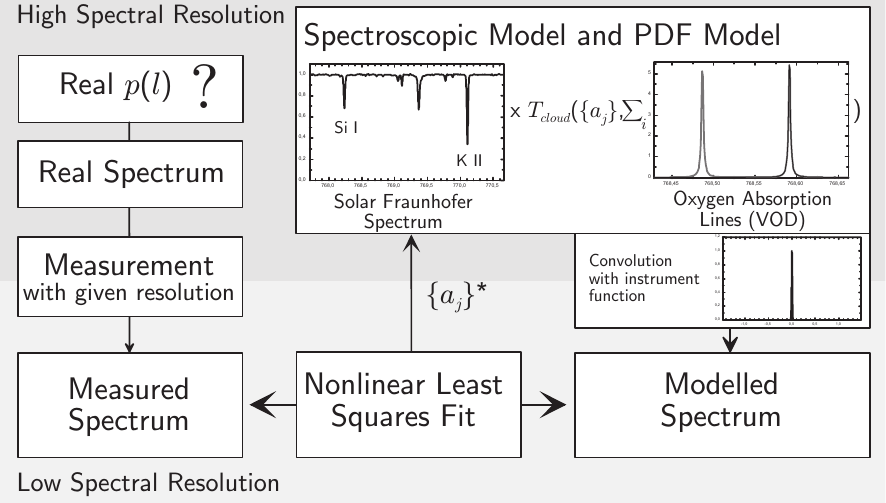
Fig. 2. Schematic view of the spectrum evaluation process. The critical spectral calculations are performed at high spectral resolution (for 100000 discrete wavelengths). The fit optimizes the parameters of the PDF model { a j } . The spectroscopic model contains a Fraunhofer reference. Additionally, terrestrial absorption above the cloud is separated from the actual cloud transmission, see Eq. (11). The convolution to measurement resolution is a critical step. Any inaccuracy in the instrument function will be compensated for by an erroneous modification of the PPD. The accuracy of the evaluation can be tested for direct light measurements, where a delta type PPD is expected.